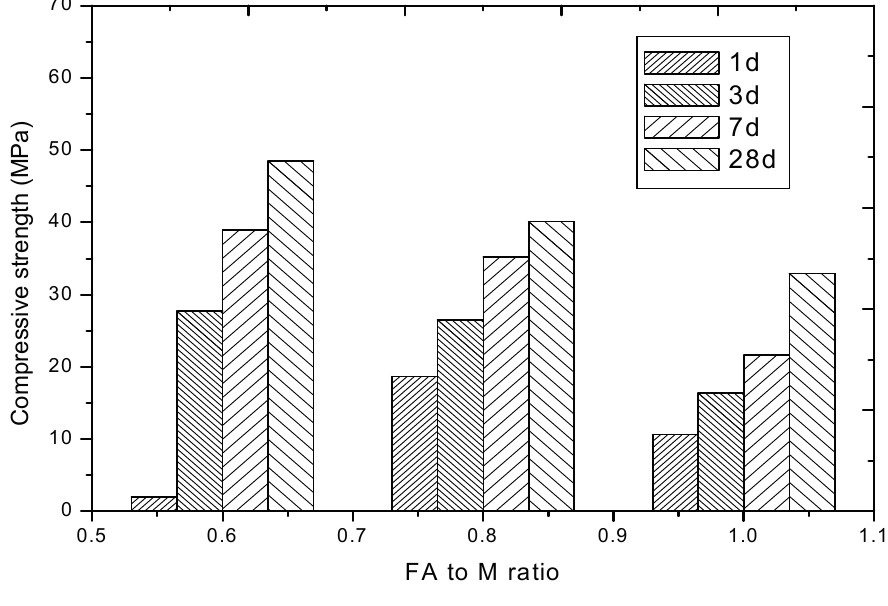
Figure 7. The effect of FA content on the compressive strength of MPC mortar (W/B (water:binder) =